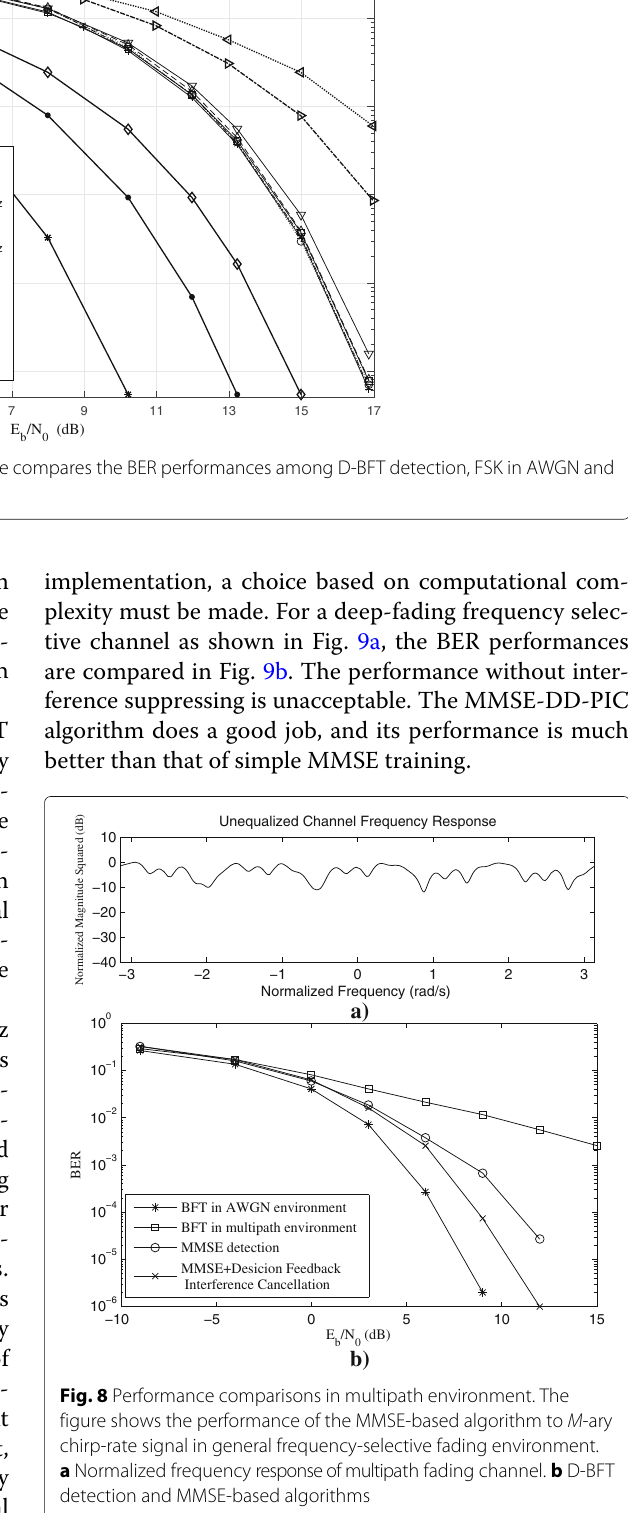
Fig. 8 Performance comparisons in multipath environment. The figure shows the performance of the MMSE-based algorithm to M -ary chirp-rate signal in general frequency-selective fading environment. a Normalized frequency responseofmultipath fading channel. b D-BFT detection and MMSE-based